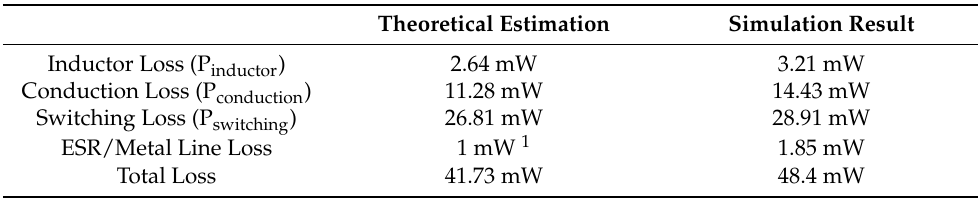
Table 2. Power loss breakdown of the proposed SIMO DC-DC